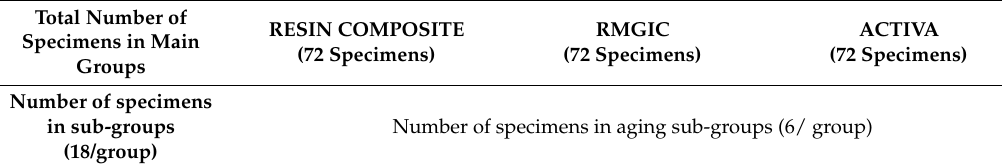
Table 2. Experimental design. Distribution of specimens in groups and sub-groups for evaluation via microtensile bond strength (MTBS), interface confocal microscopy, and SEM fractographic analysis. CTR = control, no aging; LC = load-cycling; AS = artificial